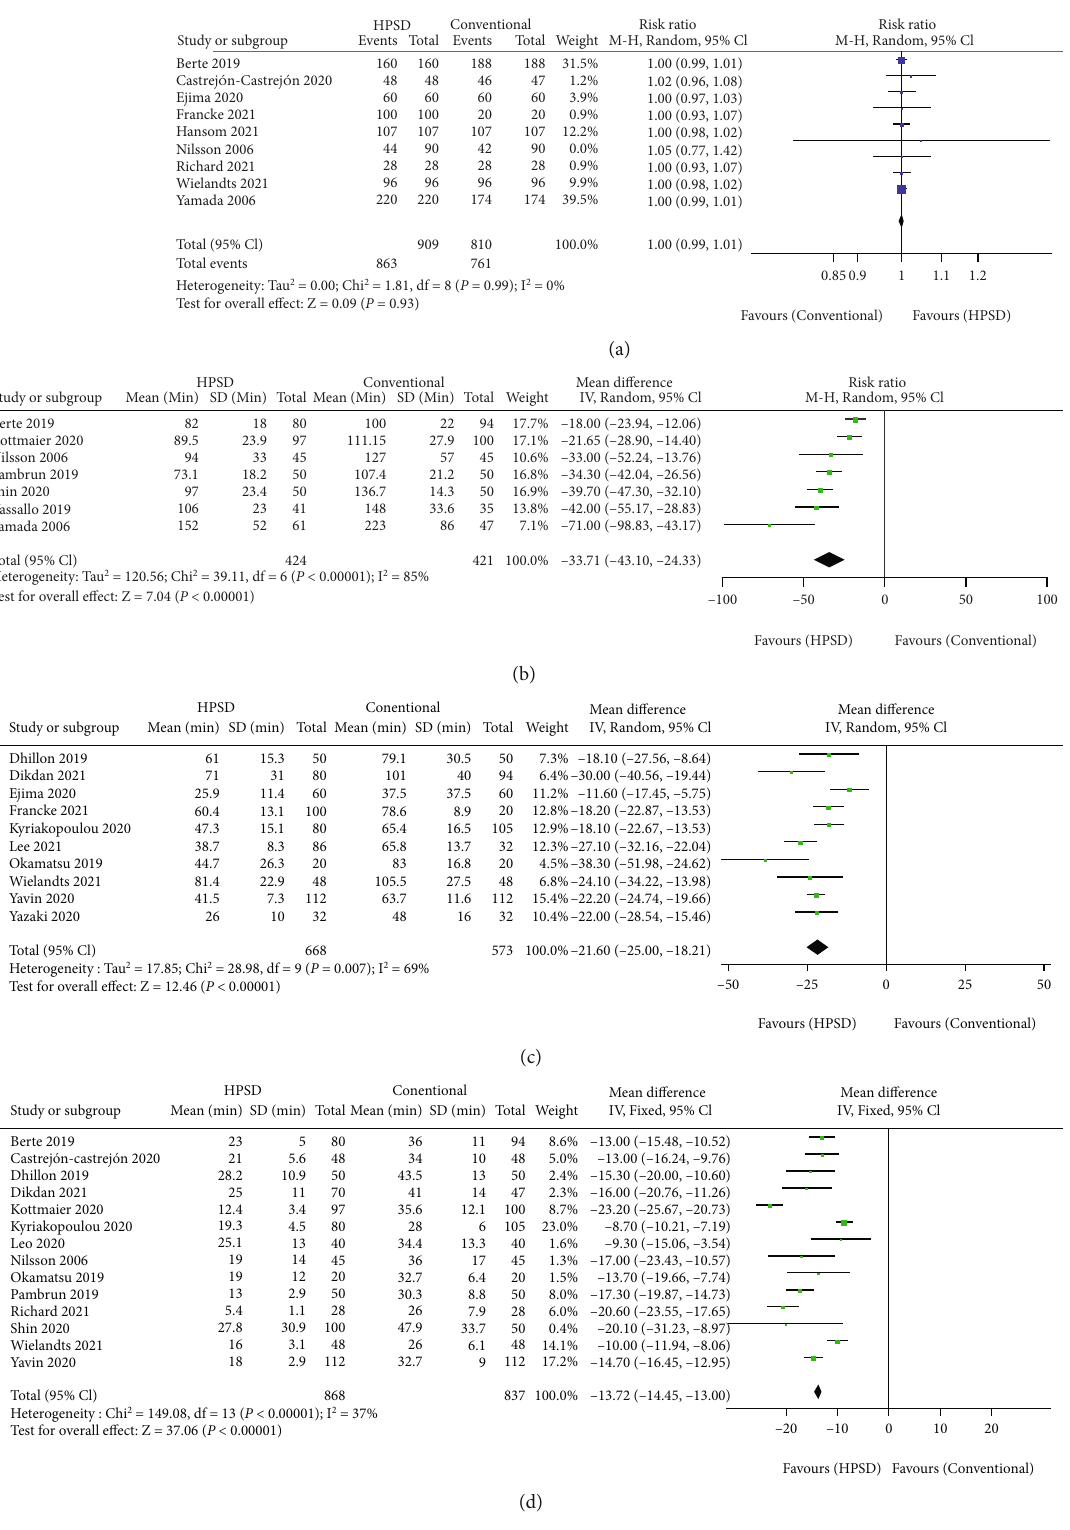
Figure 5: Forest plot of pooled e ff ect demonstrating (a) complete pulmonary vein isolation rate, (b) total procedure time, (c) pulmonary vein isolation (PVI) time, and (d) radiofrequency ablation applied time for PVI of high-power short-duration (HPSD) and conventional ablation settings. 95% CI: 95% con fi dence